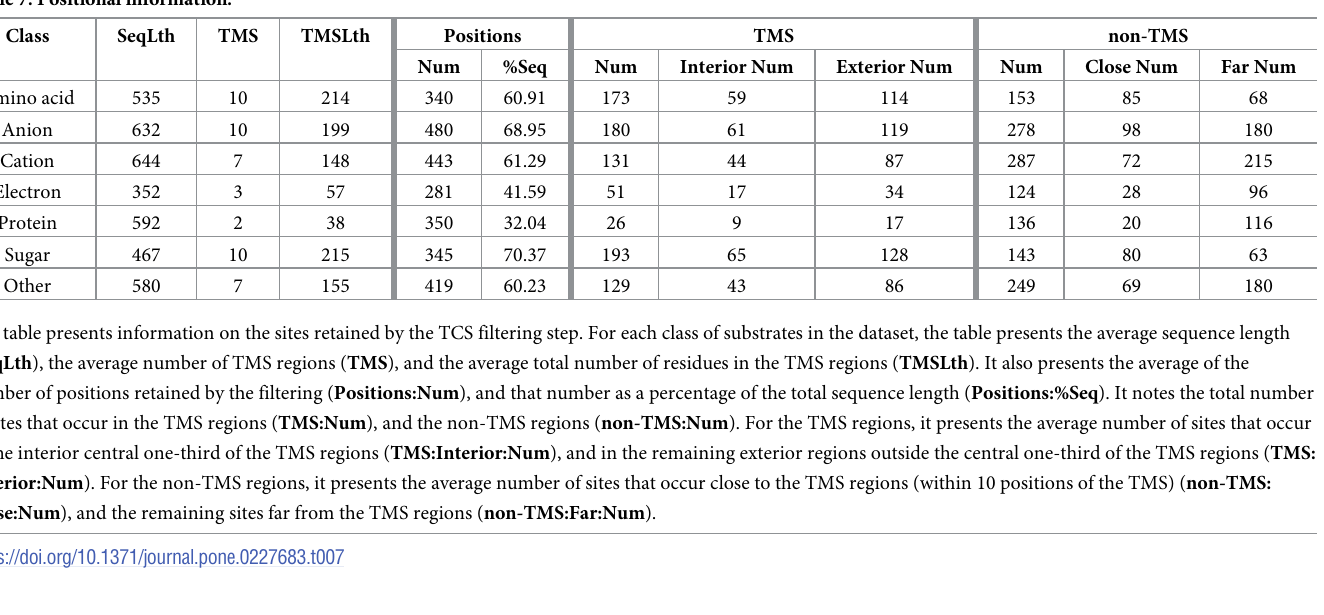
that are filtered out by TranCEP. In Fig 4(a) and 4(b), the regions with high positive average hydropathy values appear to be more informative compared to the ones with lower values. However, in Fig 4(c) and 4(d), the difference between the informative positions with high and low hydropathy values is not as clear.